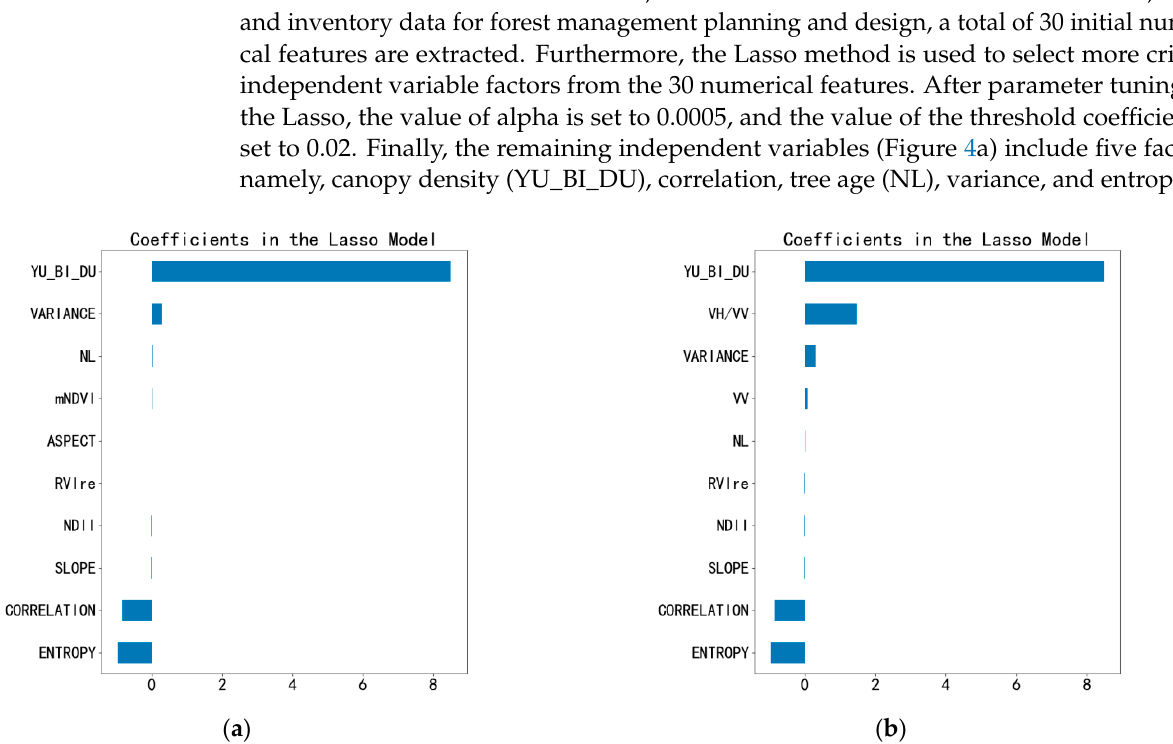
Table 5. Performance indicators for forest growing stock estimation based on data schemes A, B, C, and D.